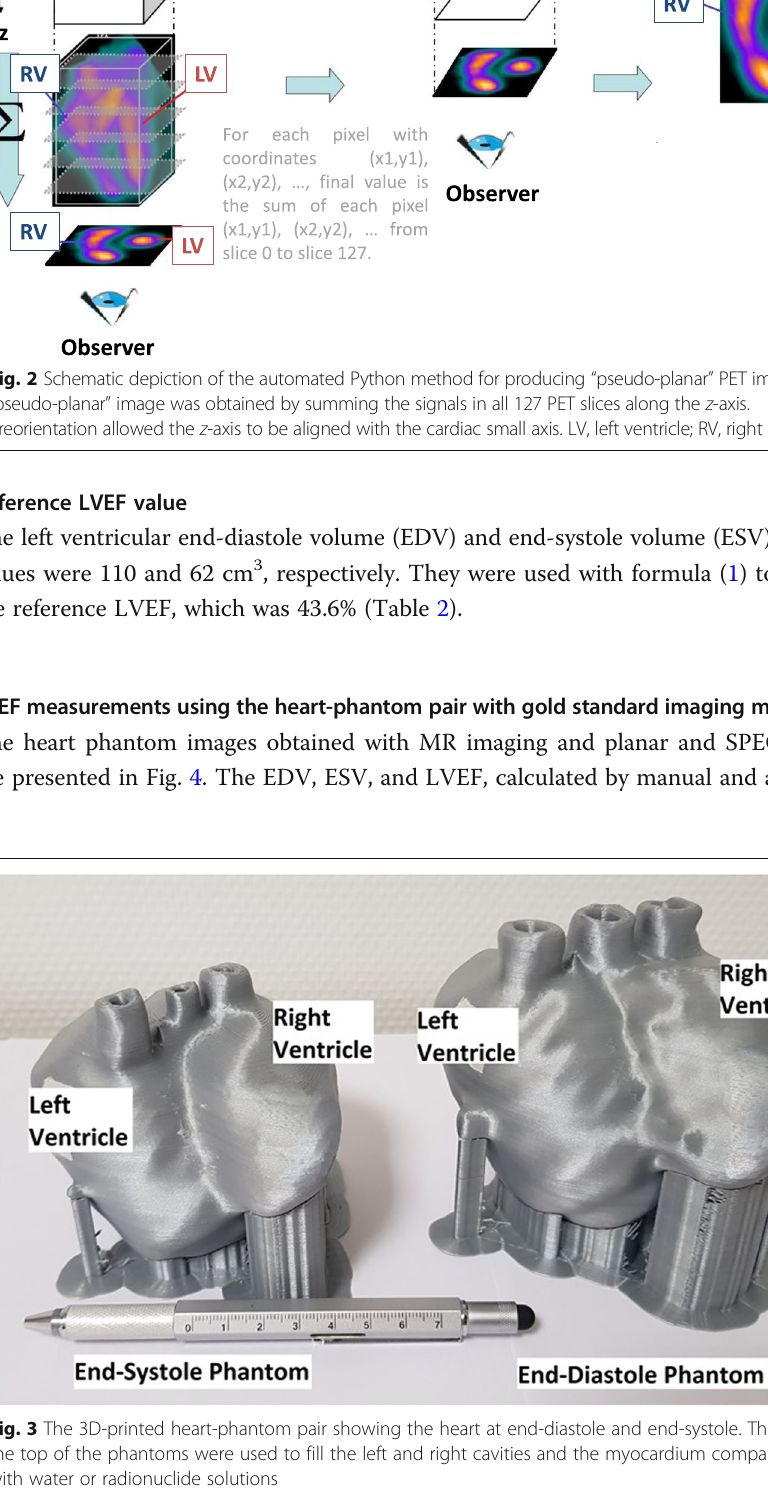
Fig. 3 The 3D-printed heart-phantom pair showing the heart at end-diastole and end-systole. The pipes on the top of the phantoms were used to fill the left and right cavities and the myocardium compartment with water or radionuclide